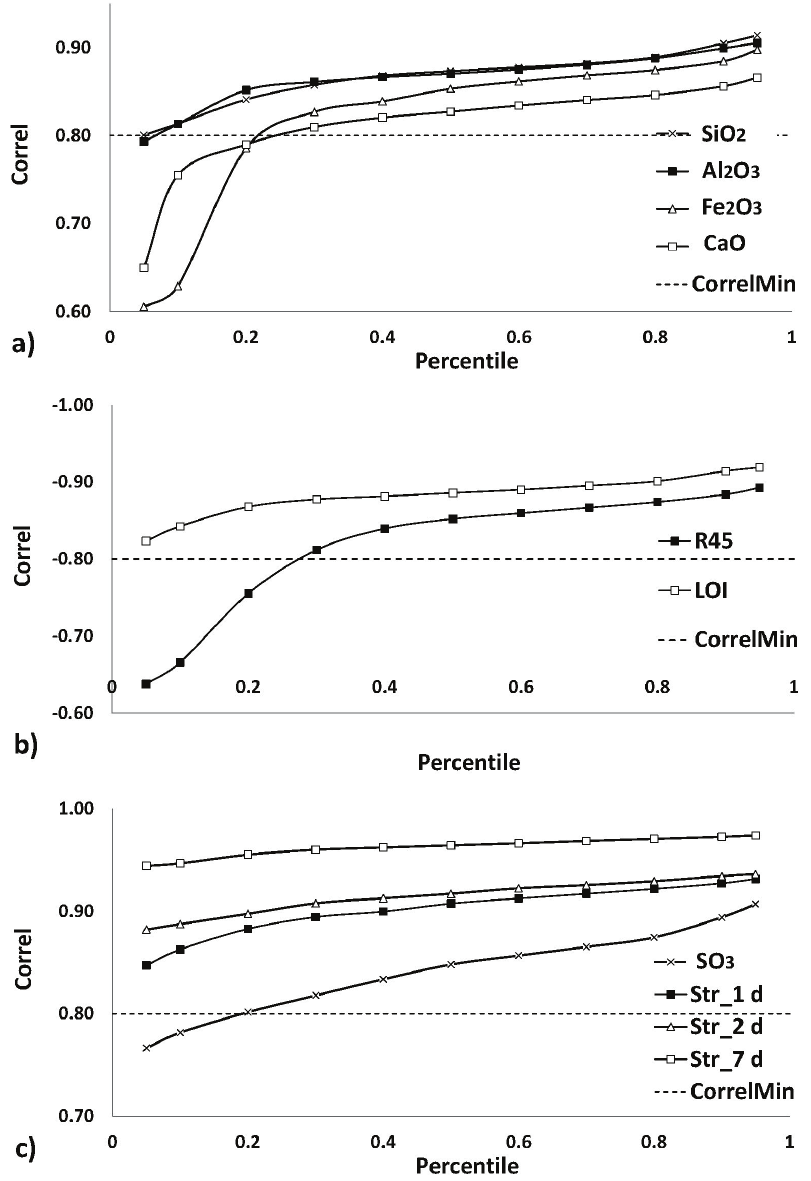
Fig. 3 – Percentiles of correlation coefficients among input variables and